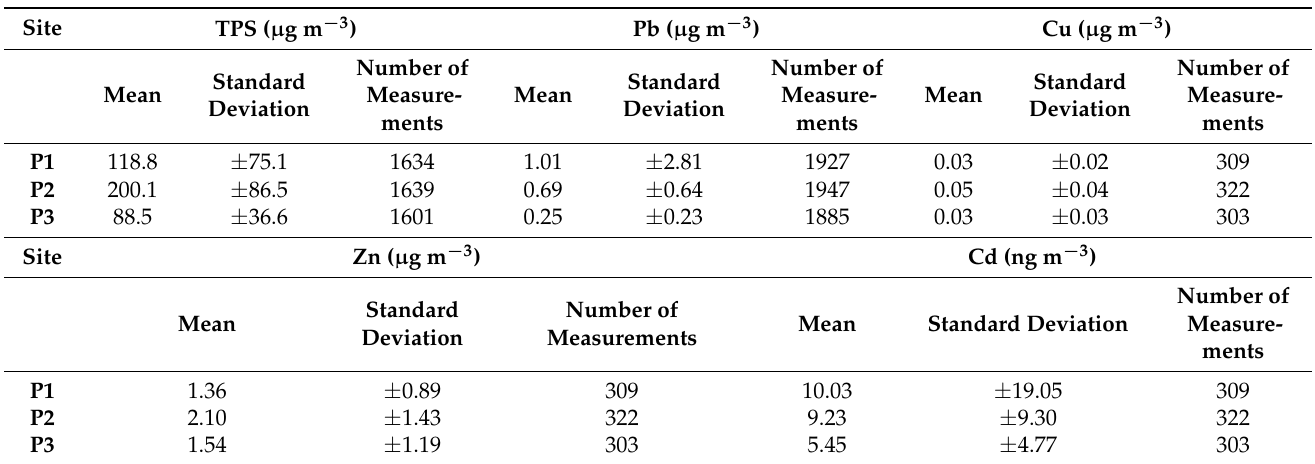
Table 5. Particulate matter and heavy metals in the atmospheric aerosol of the study area: average values over a period of 9 years [77].